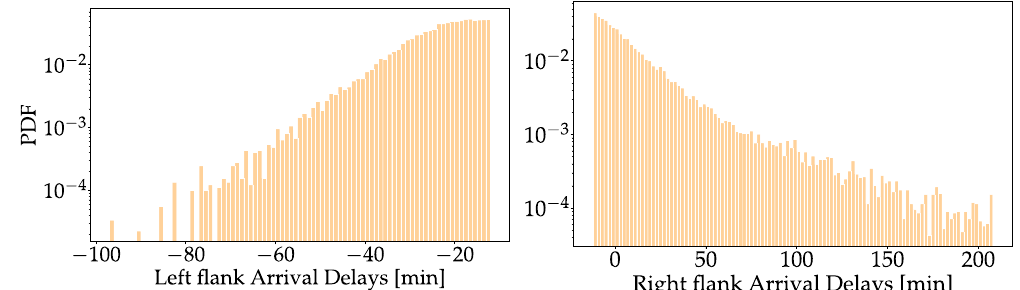
Figure 2. Splitting the full distribution at the peak leads to two easier-to-fit flanks. Left: Negative delays decay approximately linearly in the log-scale and thereby suggest an exponential fit (1). Right: Positive delays display substantial heavy tails and thereby suggest the usage of a q -exponential function (2).